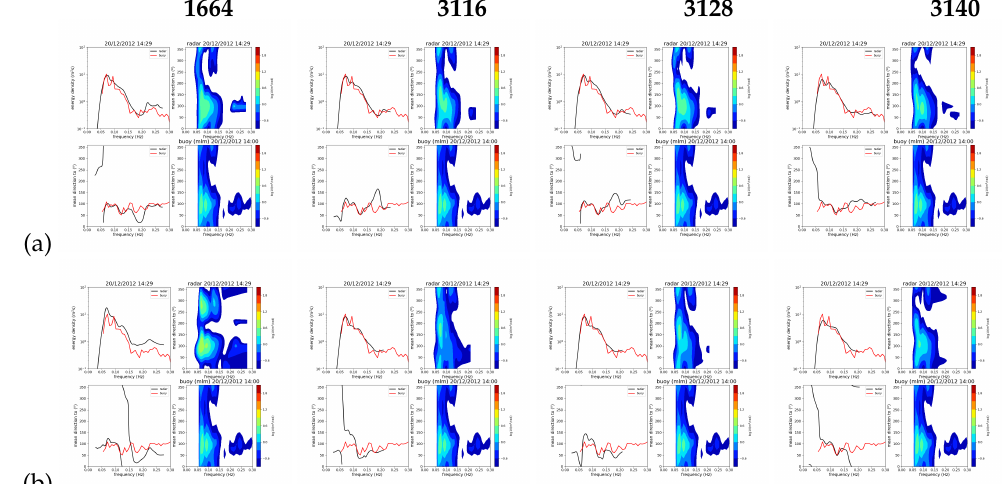
Figure 20. Inverted spectra for case 5. ( a ) monostatic ( b ) 1